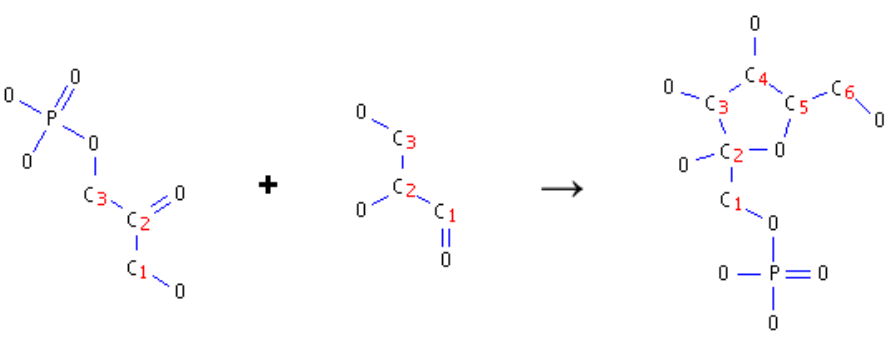
Figure 1: An example of a reaction (fructose 1-phosphate aldolase) with two substrates and a product showing the molecular structures of reactants as well as the reaction formula. EC number (here 4.1.2.13) refers to the Enzyme Commission numbering, which is a functional classification for enzymes